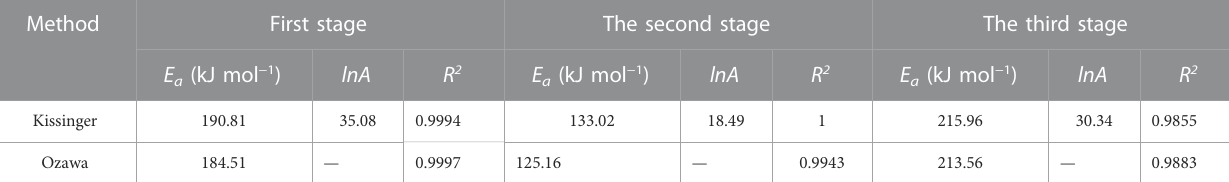
TABLE 3 Kinetic parameters obtained by Kissinger method and Ozawa method.